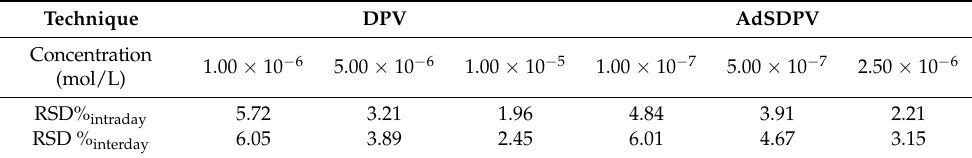
Table 4. The repeatability values for the DIO voltammetry determination on PGE_H at different